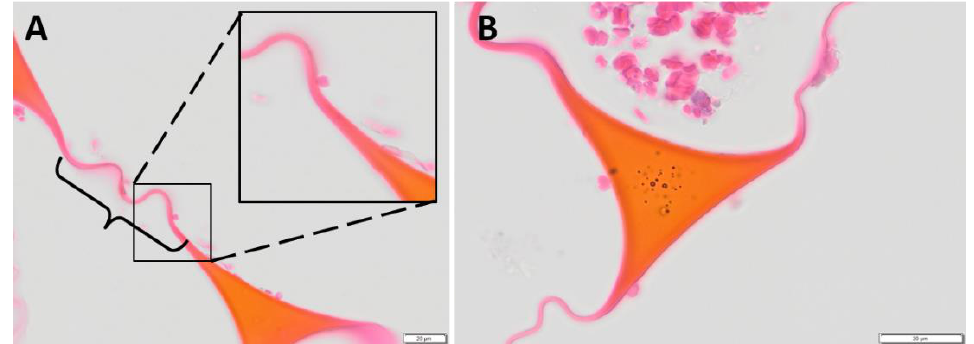
Figure 3. Zero-day images of SMP foam trans-sections show mostly intact membranes ( A ), brack- eted region). Struts transition at vertices into membranous material, magnified in the top right of image A. Struts present with smooth edges and unperturbed surfaces ( B ). These images serve as a reference for later timepoints. Zero-day foams were stained with phosphotungstic acid hematoxylin (PTAH) (20 μm) .